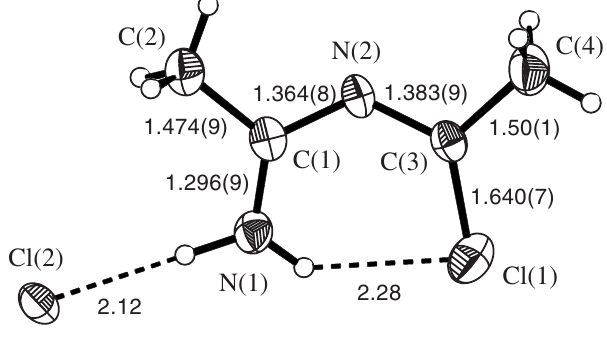
Table 2. Atomic coordinates and displacement parameters (in Å 2 )